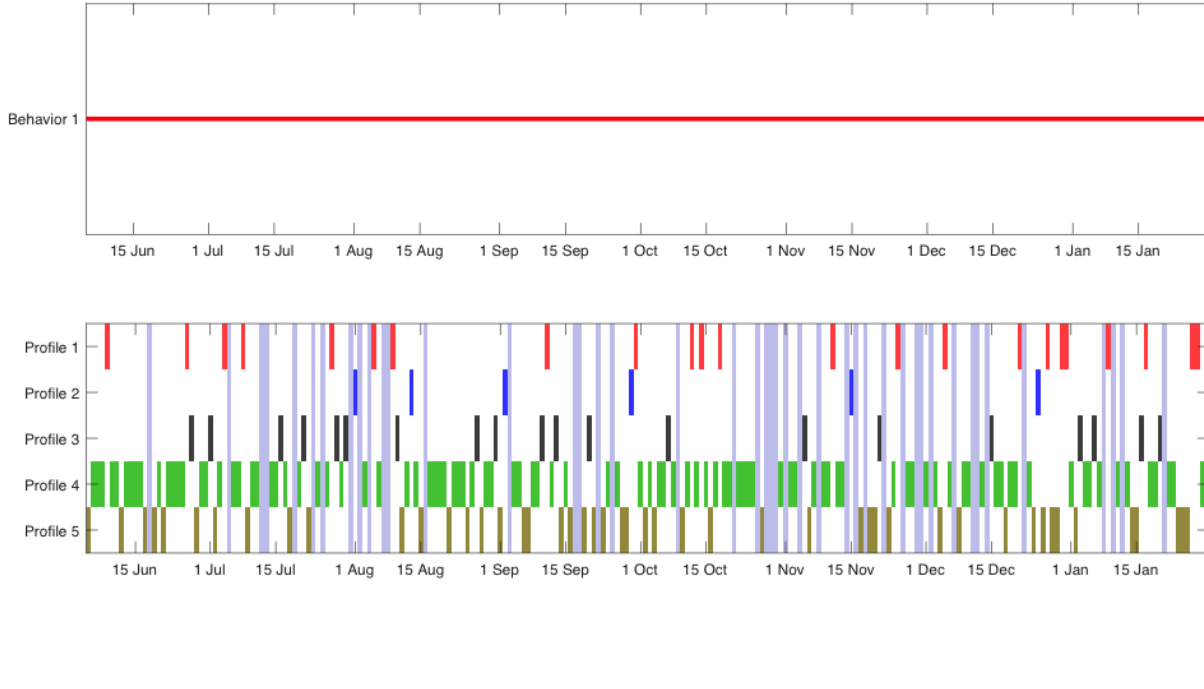
Figure 6. Representation of mobility pattern changes (above) identified by the technique and corresponding patterns (down) during study participation of patient